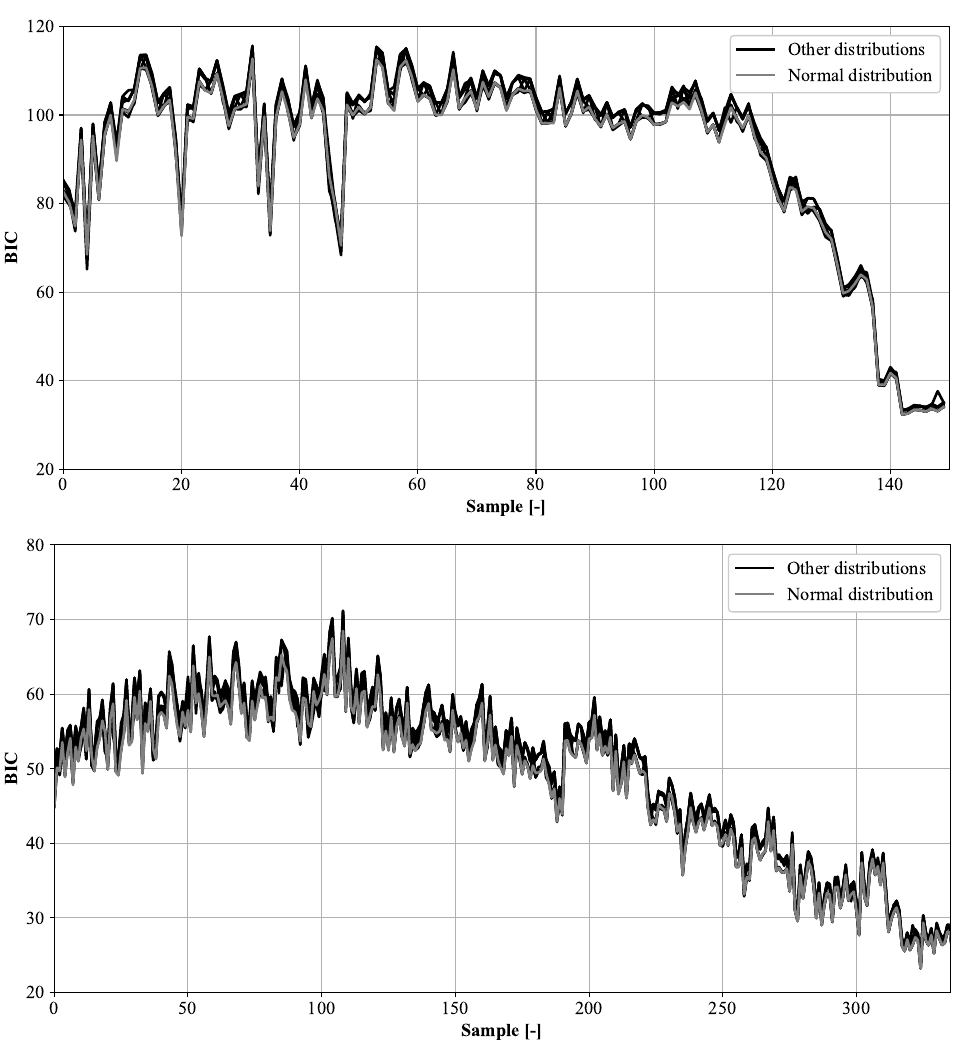
Figure A1. AIC-values of all relevant distributions for each sample of setup I ( Top ) and II ( Bottom ).